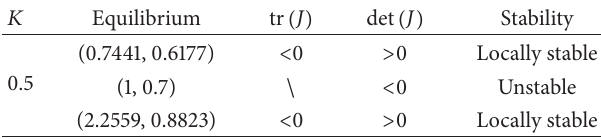
Table 2: The positive equilibrium and its